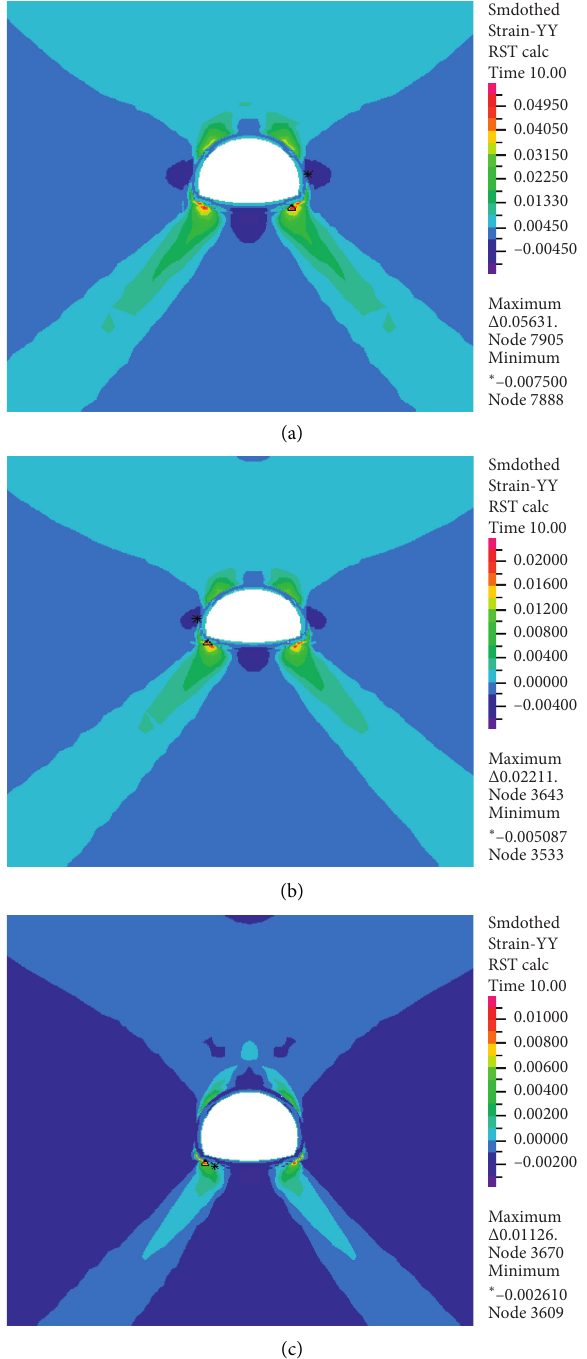
Figure 10: Plastic strain nephograms of the rock surrounding the tunnel with different overburden thicknesses: (a) 30 m, η � 2.258; (b) 60m, η � 2.261; (c) 80m, η �